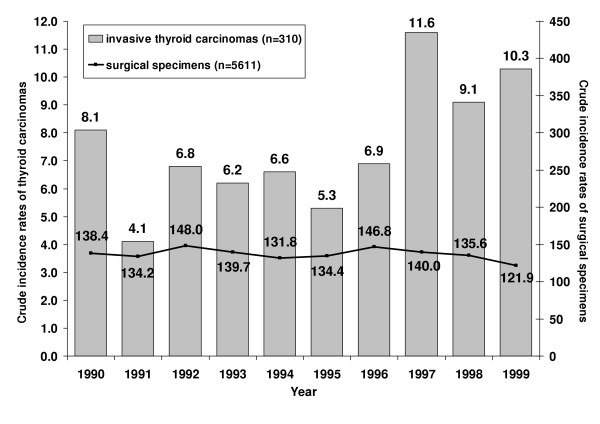
Crude incidence rates of invasive thyroid carcinomas and the surgical specimens for benign or malignant diseases for both genders, period: 1990–1999.